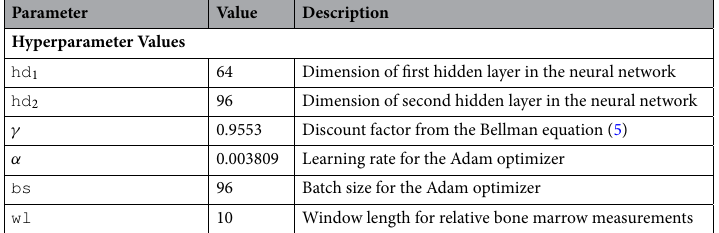
Table 2. Hyperparameter values for the learning process. The parameters hd 1 , hd 2 , γ , α , and bs were determined by the Bayesian optimizer whereas wl was chosen